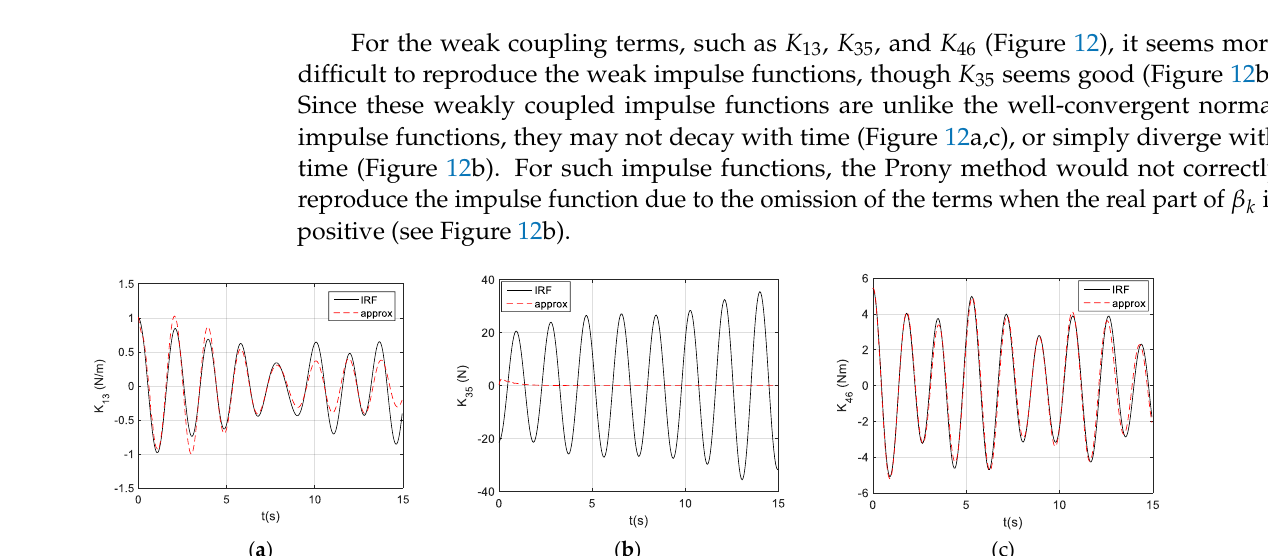
13 ; ( b ) K 35 ; ( c ) K 46 .